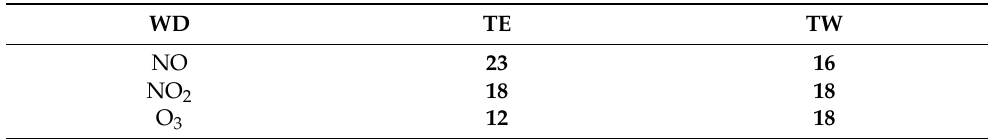
Table 6. The number of extreme values out of 24 in 2020 using averaged hourly data from April to June for weekdays. p -Values < 0.01 for 11 or more are shown in bold. The extremes for ozone are maximum values; the extremes for NO and NO 2 are minimum